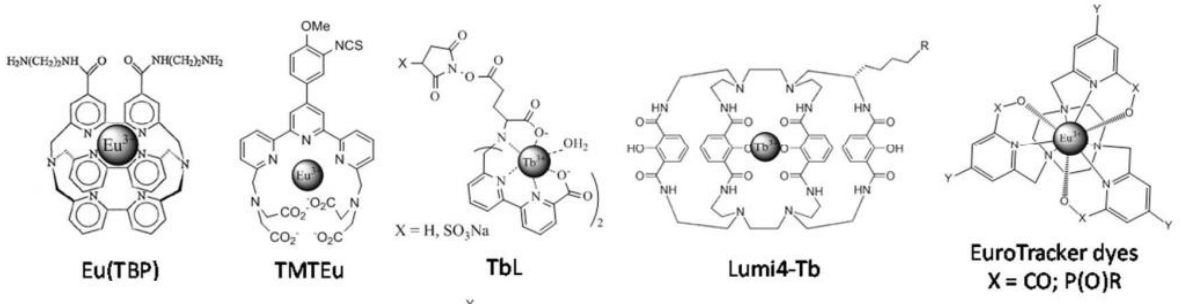
Figure 11. Schematic representation of a luminescent lanthanide label. Reproduced from [149], with permission from RSC Publisher, 2016.